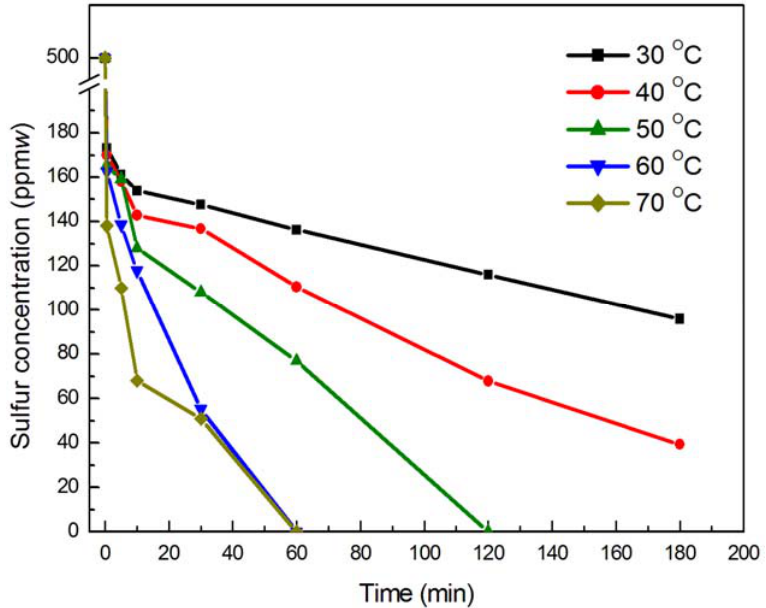
Figure 3. The effect of different temperatures on ODS of simulated oil. Experimental conditions: pre-reaction time 10 min; O/S molar ratio 20; the amount of catalyst used was 1% the mass of n -octane; and DBT (S: 500 ppm( w ) in n